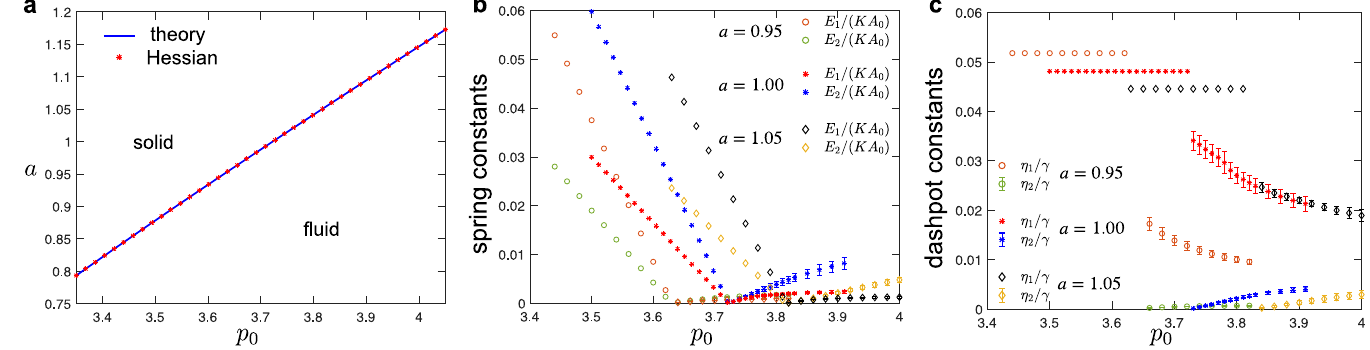
Fig 10. Tuning the solid to fluid transition by applying uniaxial pre-deformation. (a) The solid-fluid transition boundary in the a − p 0 plane, where a measures the � � . Blue line shows the analytical prediction from Eq (11), which matches the amount of uniaxial pre-deformation described by the deformation gradient ^ F ¼ a 0 0 1 stability analysis with the Hessian matrix (red dots). (b,c) The fitted values of the (b) spring and (c) dashpot constants for the SLS model in the solid phase [see Eq (5)] and the Burgers model in the fluid phase [see Eq (8)] when the system is under uniaxial compression ( a = 0.95), no pre-deformation ( a = 1.00), and under uniaxial tension ( a =